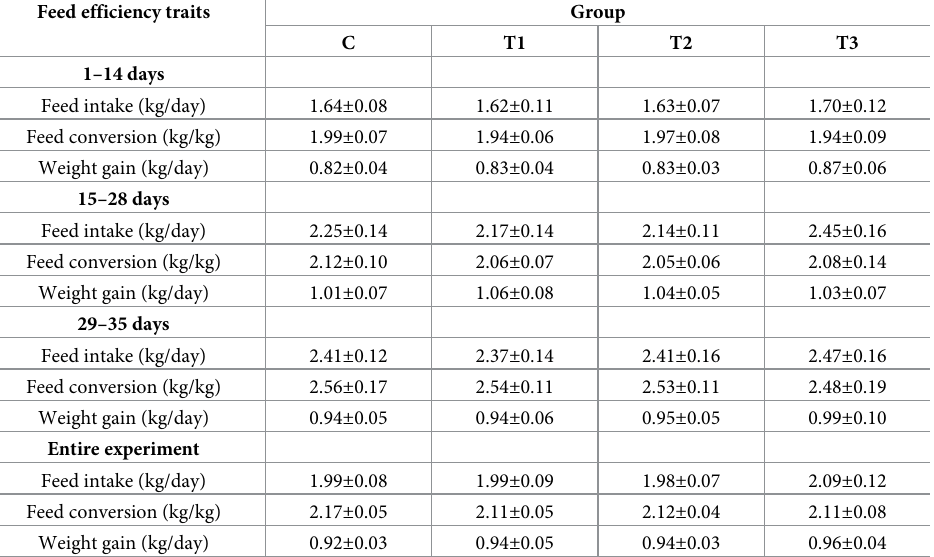
Table 4. Growth performance of pigs.